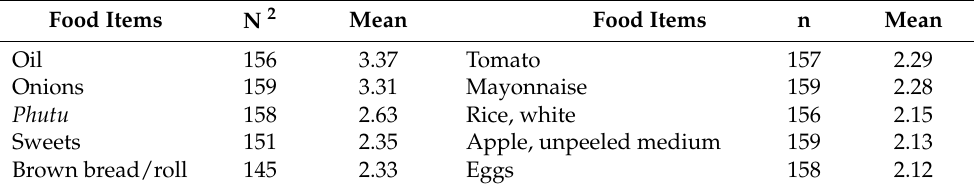
Table 9. The mean frequency scores 1 for the ten most commonly consumed food